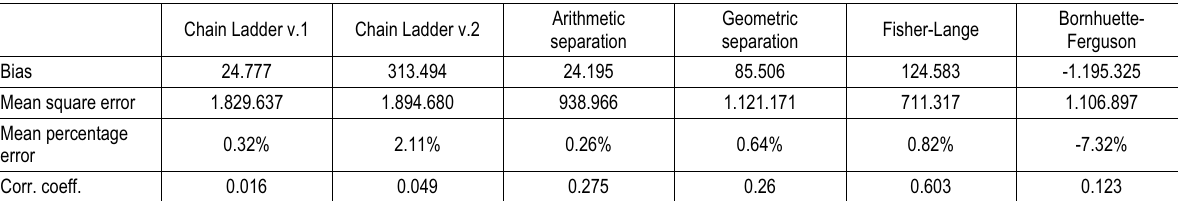
Table 1. Method of random development factors